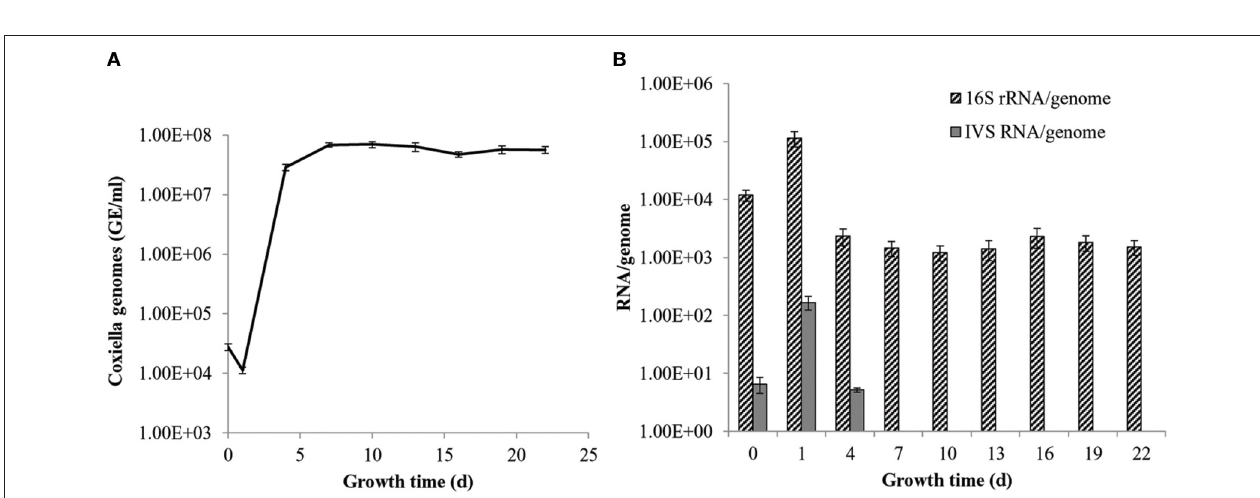
FIGURE 9 | Levels of IVS RNA in C. burnetii over time of growth. (A) q-PCR data showing C. burnetii genome equivalents per ml (GE/ml) during growth in ACCM-2. (B) qRT-PCR data showing numbers of 16S rRNAs (striped bars) and IVS RNAs (gray bars) on a per genome basis. Data represent the means of six independent experiments ± S.D., except IVS data at 0 d, which represent the mean of three determinations ±